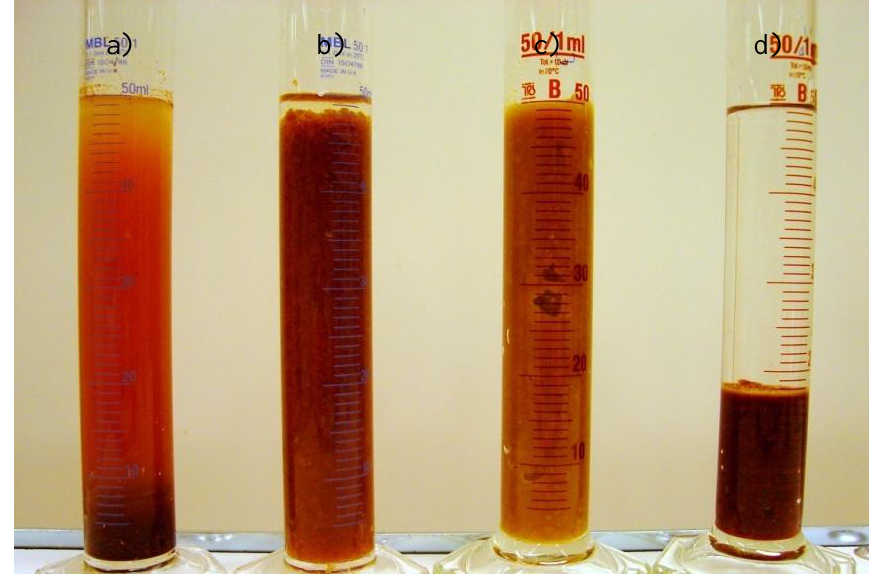
Figure 3. ( a ) hydrolysed fiber, ( b ) un-hydrolysed fiber, ( c ) low lignin fiber, ( d ) high lignin fiber. The amounts of dry matters in all cylinders were 2 g. The hydrolysed fibers ( a ) settles very fast and the supernatant was a cloudy liquid. Unhydrolysed fiber ( b ) settled to final volume of about 4 g/100 mL and low lignin content fibers ( c ) never settled. However, the high lignin content fibers ( d ) settled very fast and supernatant was clear